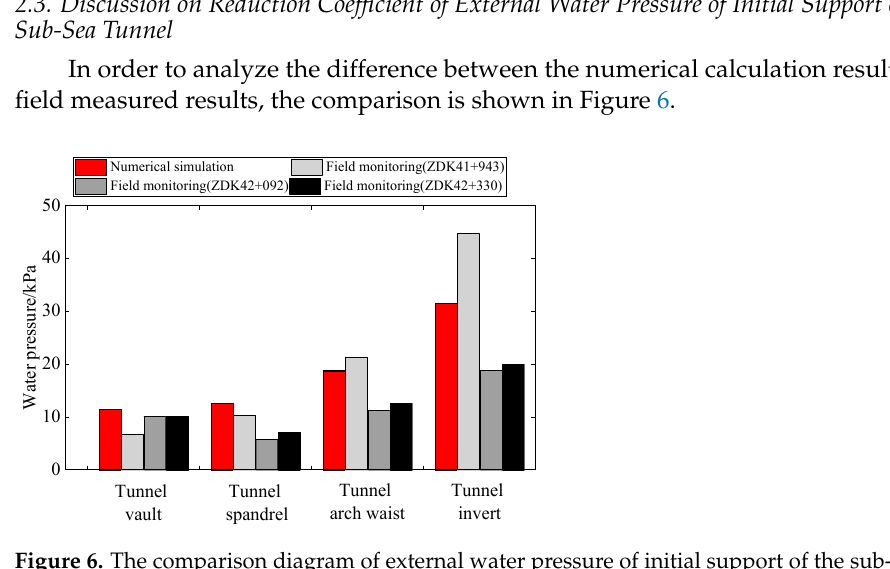
Table 4. Recommended value of water pressure reduction coefficient of class A surrounding rock. k r /k g